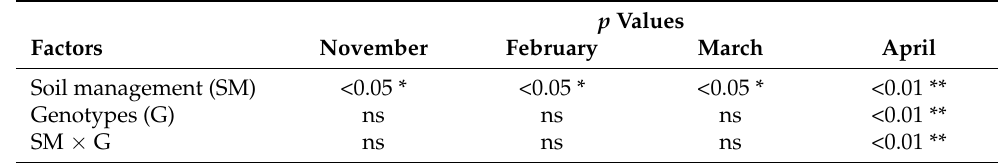
Table 3. Significance of the combined effects of soil management practices and genotypes on total cover of weeds.